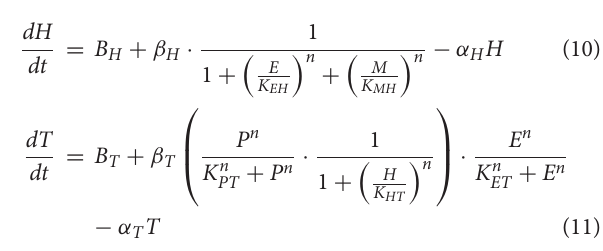
FIGURE 3 | Correlation analysis of gene expression profiles. (A) Local weighted correlation for Hth/Ey, Ey/Optix, and Eya/Hth showing three parameters: their mean (solid line), their Fano’s factor (as a measure of signal variability, or “noise,” dashed line) and their weighted local correlation (gray ribbon). Ribbon width corresponds to a confidence interval with α = 0.05. (B) Potential regulatory interactions that are compatible with the correlation analysis (see main text for details). (C) Hth-expressing clones (marked with anti-Hth) in an optix2/3-dGFP eye disc. Most hth clones repress optix2/3 cell-autonomously (yellow arrowheads). A clone adjacent to the MF does not show this repression (white arrowhead). Merged and optix2/3-dGFP-only channels are shown. (D) Clones simultaneously expressing ey- RNAi and toy- RNAi (marked in green, yellow arrowheads). In these clones Hth expression is upregulated. Merged and Hth-only channels are shown; a white line delineates two confocal planes obtained from the same imaginal disc. Nuclei in (C) and (D) are counterstained with